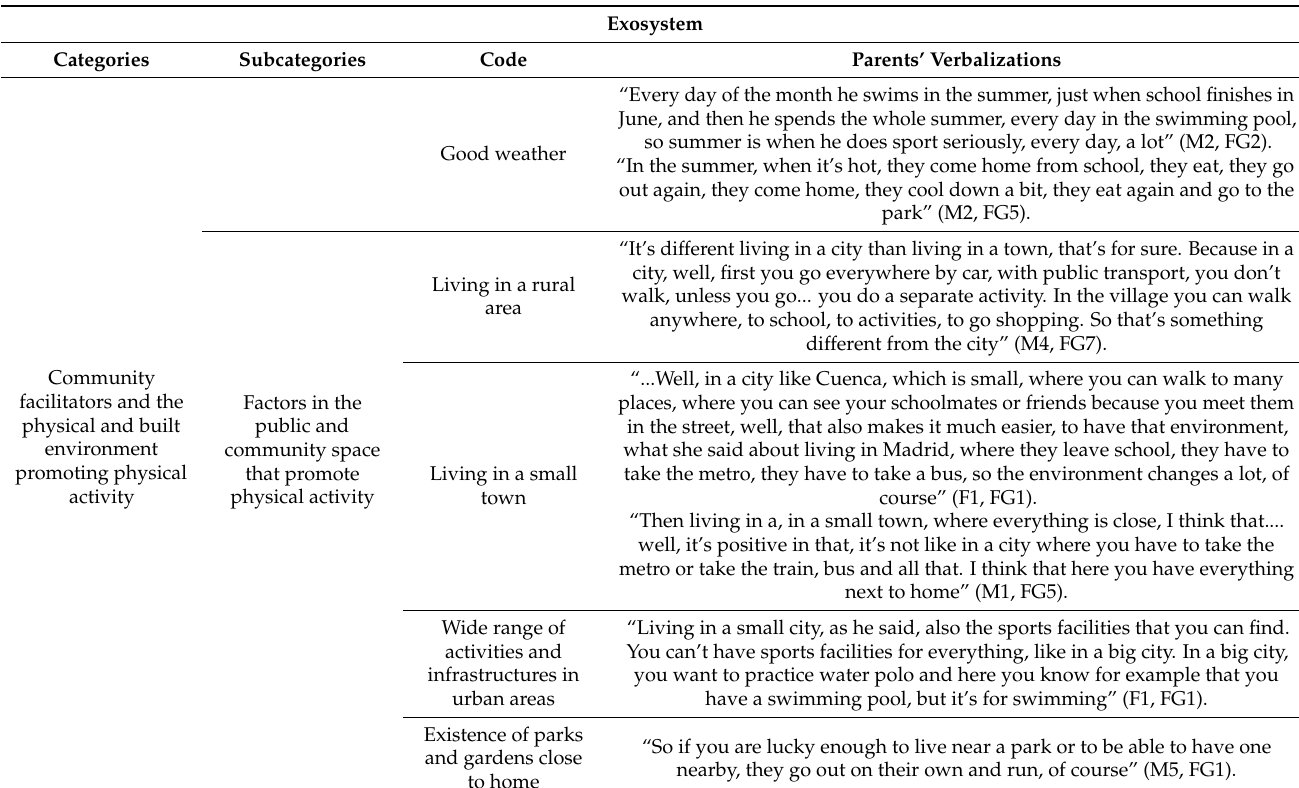
Table 11. Exosystem facilitators for physical activity among